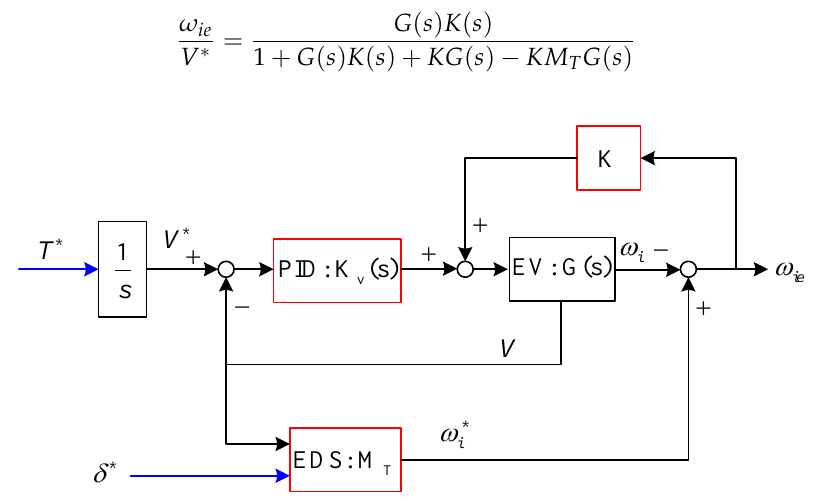
Figure 11. Control block diagram of proposed scheme.